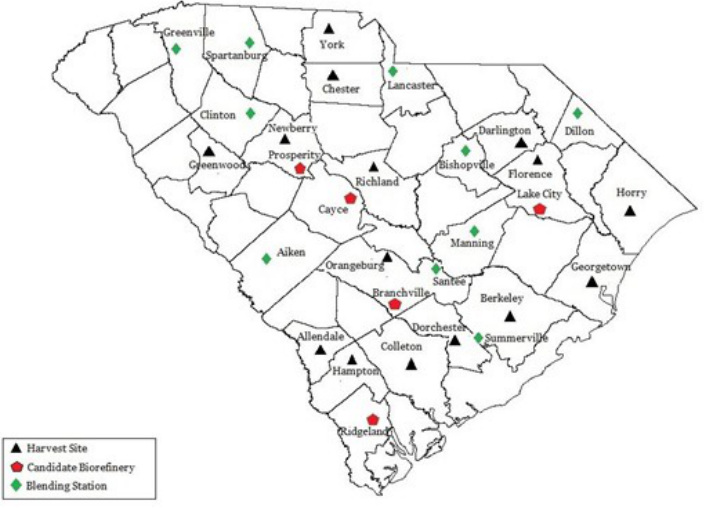
Figure 3. Candidate Biorefinery, Harvesting Sites, and Blending Stations